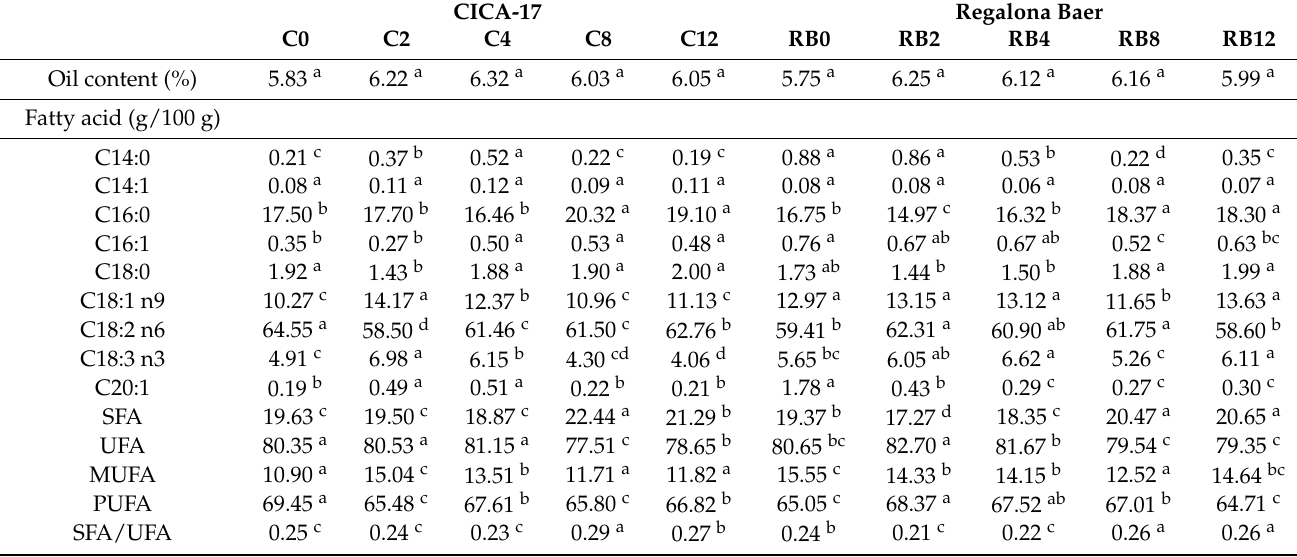
Table 4. Fatty acid compositions of quinoa seed oil of CICA-17 and Regalona Baer varieties under different goat manure